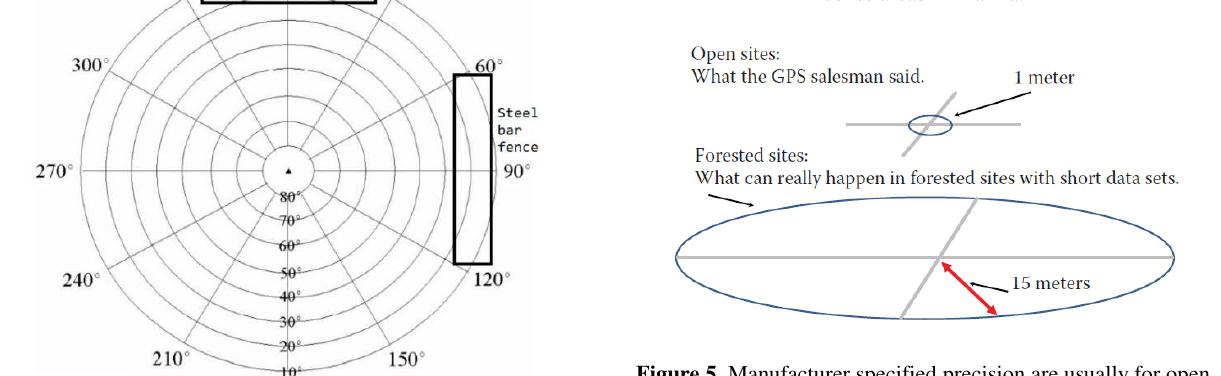
Figure 4. Visibility obstruction diagram of station TEST, simulating observations done in urban canyons and highly dense areas in Manila.